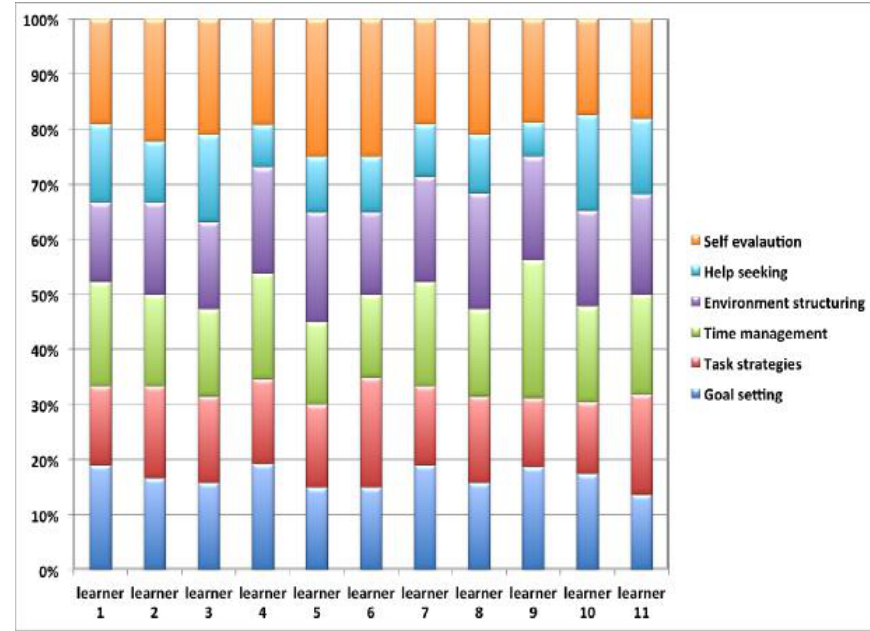
Fig. 3. Visualisation of associated responses from